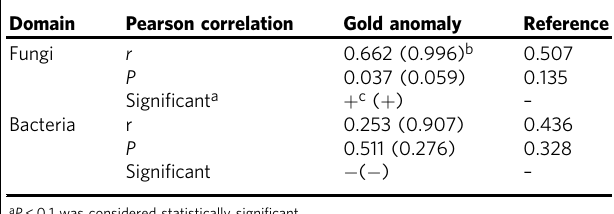
Table 3 Pearson correlation between inverse Simpson index and in situ gold concentrations